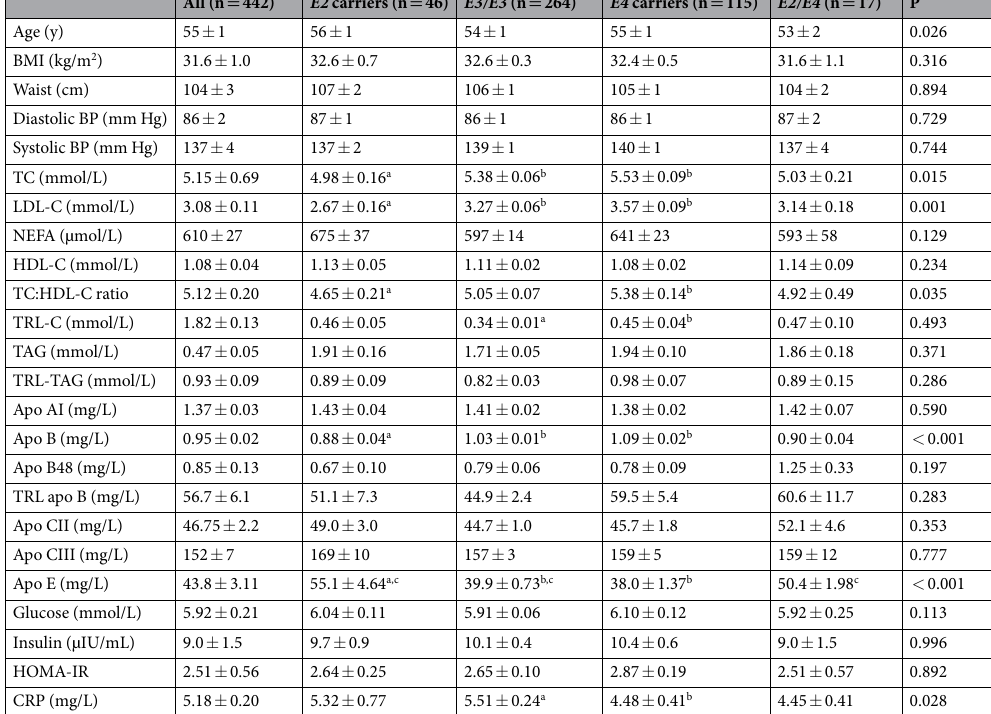
Table 2. Effect of the APOE genotype on anthropometric variables, blood pressure, fasted plasma- and serum- profiles in the LIPGENE Dietary Fatty Acid Intervention Study ( n = 442; males n = 194, females n = 248). Abbreviations: BMI, body mass index; SBP, systolic blood pressure; DBP, diastolic blood pressure; TC, total cholesterol; LDL-C, low-density lipoprotein cholesterol; HDL-C, high-density lipoprotein cholesterol; NEFA, non-esterified fatty acid; TAG, triacylglycerol; TRL-C, triglyceride rich lipoprotein cholesterol fraction; TRL-TG, triglyceride rich lipoprotein triglyceride fraction; CRP, C-reactive protein. Values are means ± s.e.m. Models were adjusted for center, gender, age and BMI. Where P for genotype < 0.05, a post-hoc Bonferroni test were used to determine a between group effect. Superscript letters a and b denote significant differences in means (P <